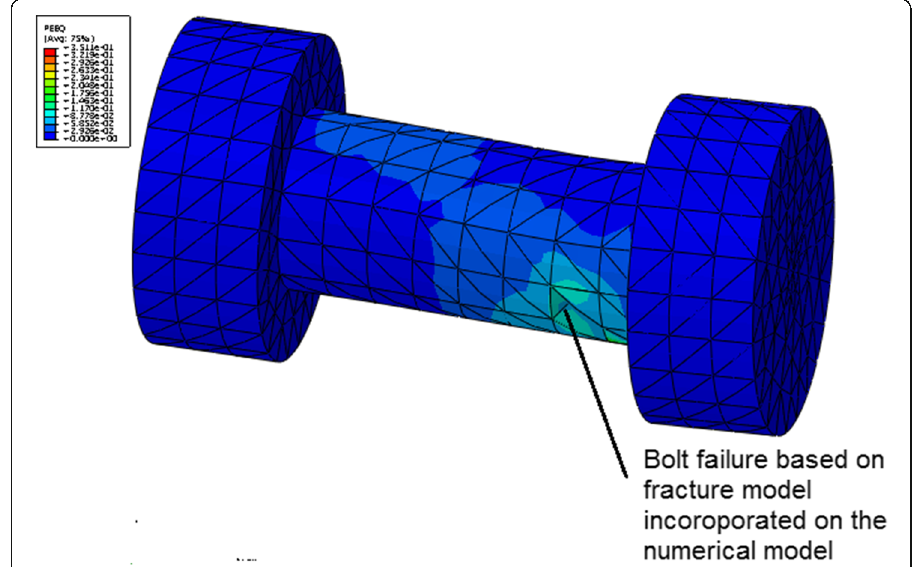
Figure 22 shows different time duration versus corresponding pressure values for connection SC2. The same time durations are used for SC3 and DR1 with different pressure values. The problem examined is an explosion inside a fully vented room of dimensions 6.0 × 6.0 × 6.0 m. Only half the frame was considered for analysis due to symmetry. For the case of fully vented room (i.e., one wall missing), the gas pressure may be neglected as per UFC 340-02 [14].